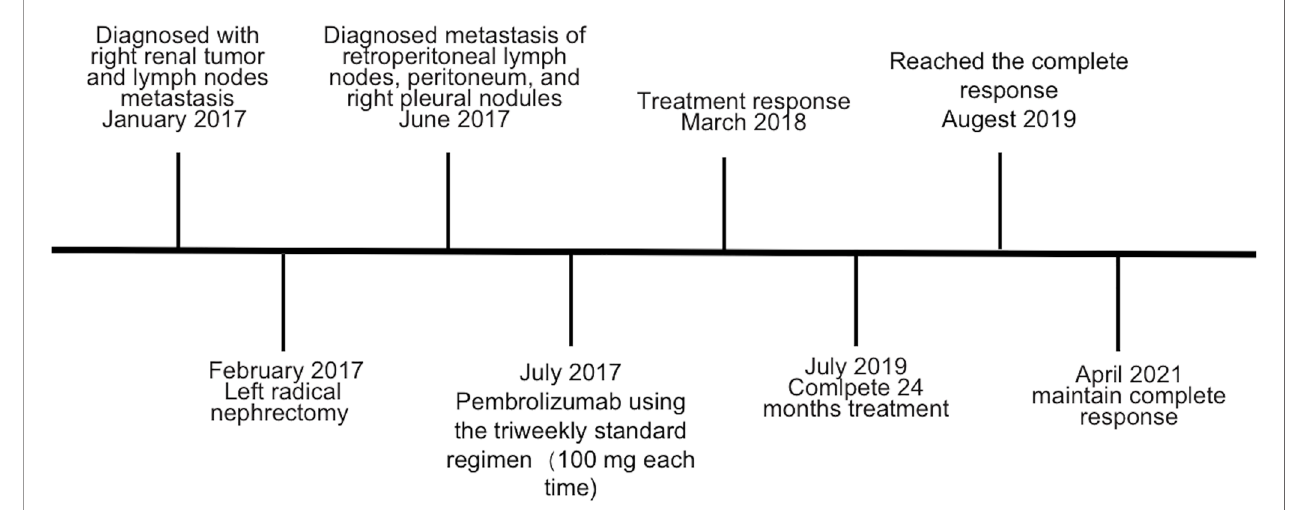
FIGURE 4 | Timeline of the